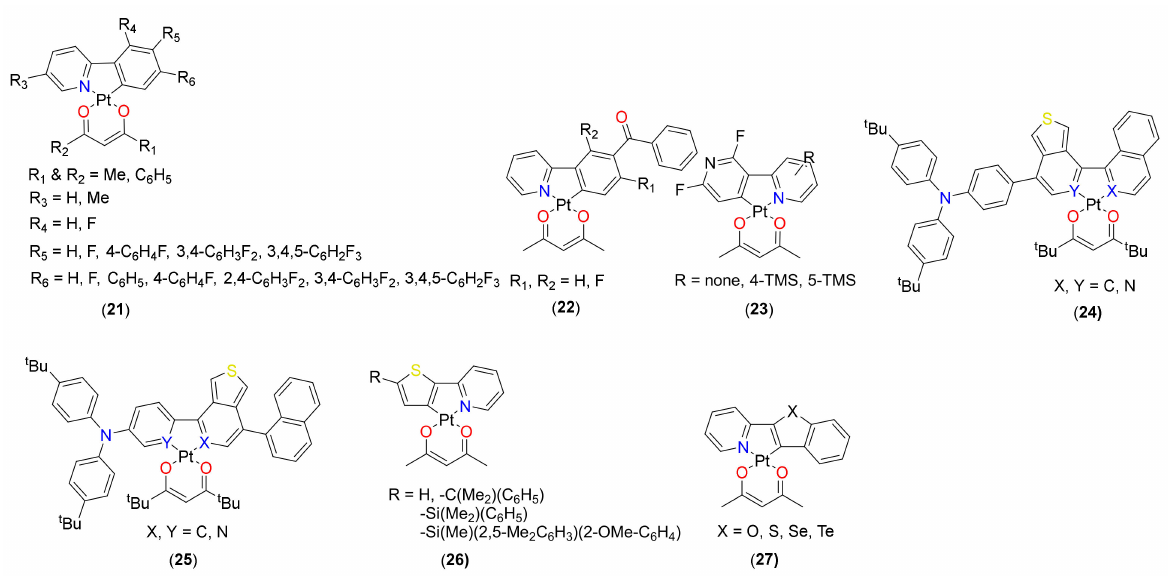
Figure 5. Pt(II) complexes based on 2-phenylpyridine, 2-thienylpyridine, 2-phenylbenzimidazole, etc. cyclometalating ligands and β -diketonate derivatives as ancillary